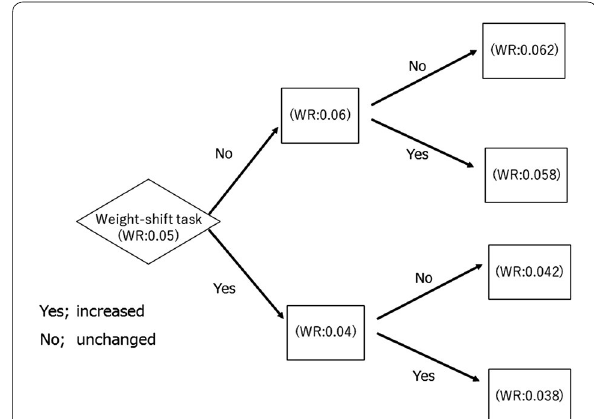
Fig. 4 Derivation process of the Weber ratio (WR). After the repeated weight-shift task, participants responded whether or not they felt an increase in the amount of weight shifting according to two condi- tions (response options “Yes; increased”, “No; unchanged”)